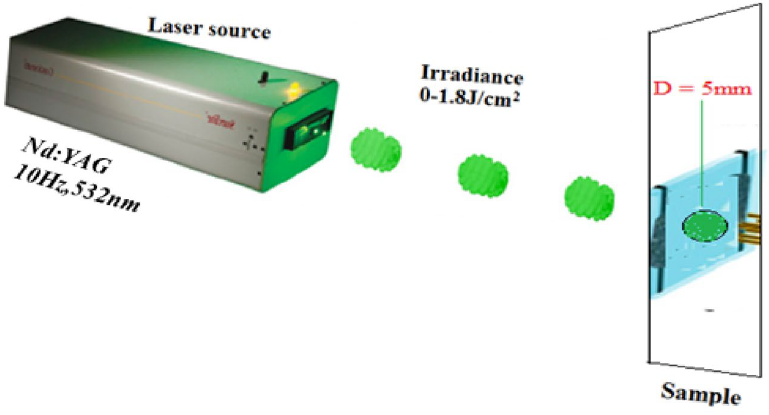
Figure 1. Nd :YAG Green laser set-up diagram used for irradiating the ZnO-CdO coated